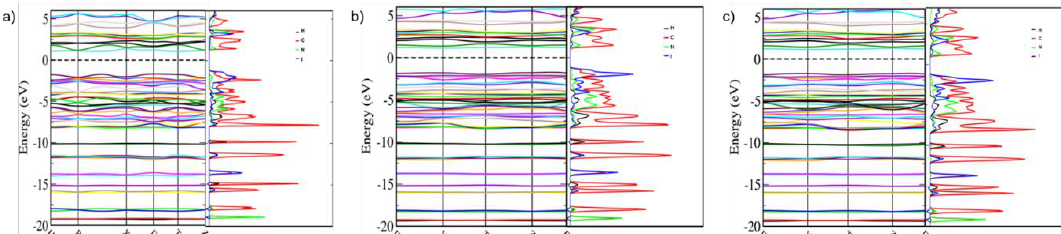
Figure 11. Band structure and electronic density of states of 4-iodobenzonitrile at ( a ) 5 GPa, ( b ) 5.5 GPa and ( c ) 8.14 GPa. The density of states are shown projected onto their atomic species where hydrogen—black, carbon—red, nitrogen—green and iodine—blue.